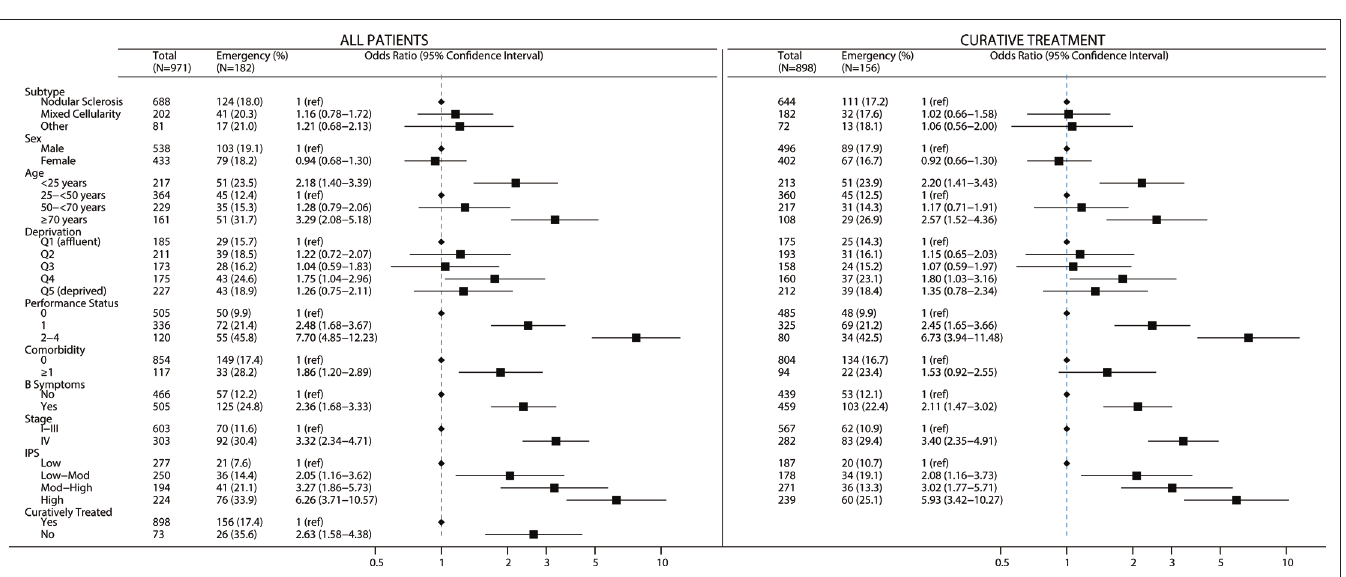
Figure 1 Patients with classical Hodgkin lymphoma distributed by demographic and clinical prognostic characteristics, with ORs (95% CIs) for diagnosis following emergency admission presented for all patients and those treated with curative intent (data from HMRN diagnoses 2004–2015). IPS = International Prognostic